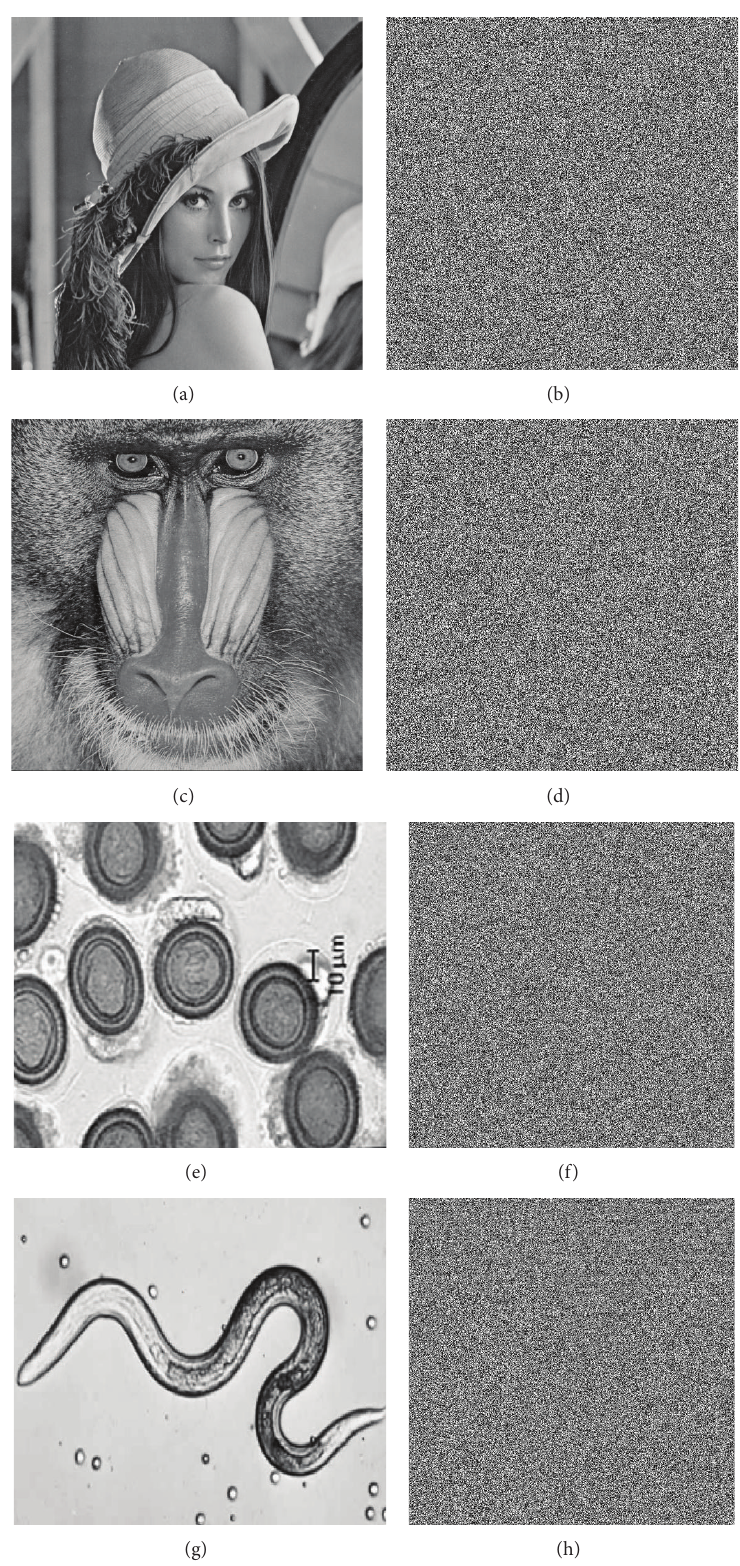
Figure 3: Encryption by the proposed scheme using the secret key “23421100452972604309100881297041.” Frames (a) and (b) show a plain image “Lenna” and its corresponding cipher image, respectively. Frames (c) and (d) show a plain image “Baboon” and its corresponding cipher image, respectively. Frames (e) and (f) show a plain image “ Taenia saginata ” and its corresponding cipher image, respectively. Frames (g) and (h) show a plain image “ Toxocara canis ” and its corresponding cipher image,